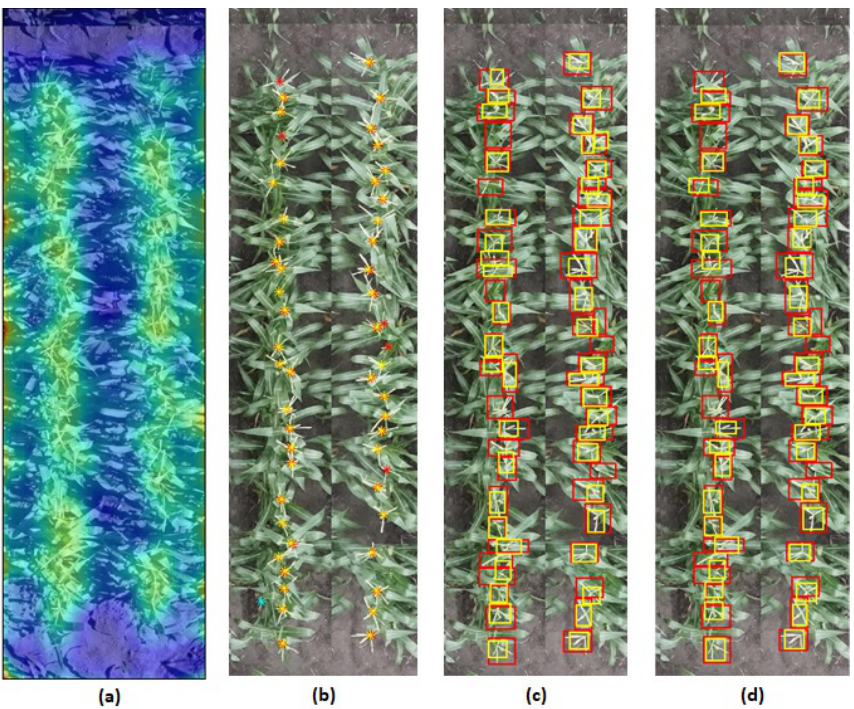
Figure 15. Results of Test Subset 12 (Ng: Red, TP: Yellow, FP: Cyan). ( a ) TasselNetv2+. ( b ) CenterNet. ( c ) TSD. ( d ) DetectoRS.